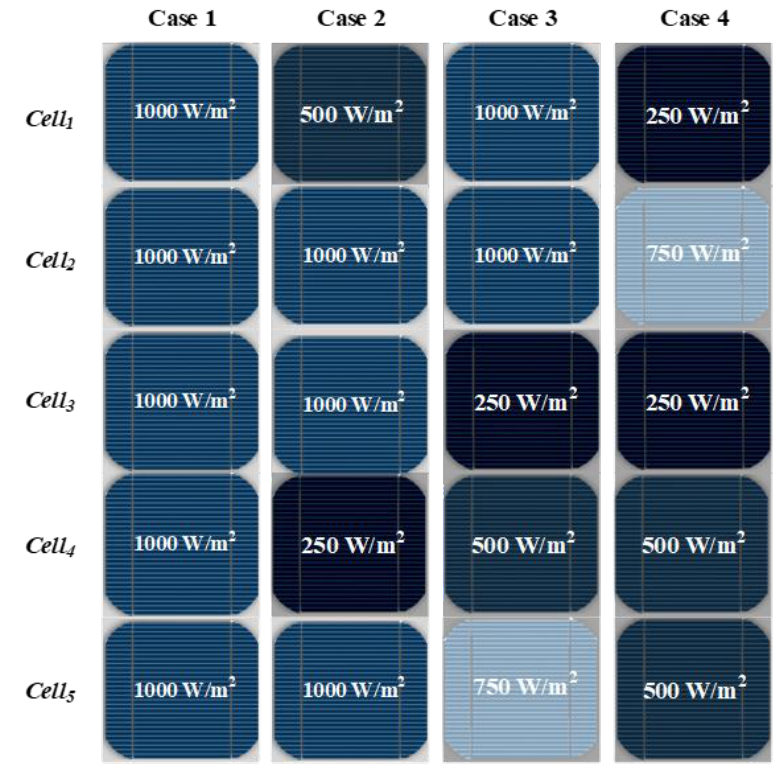
Figure 9. Mismatch cases with different irradiances over the PV cells.